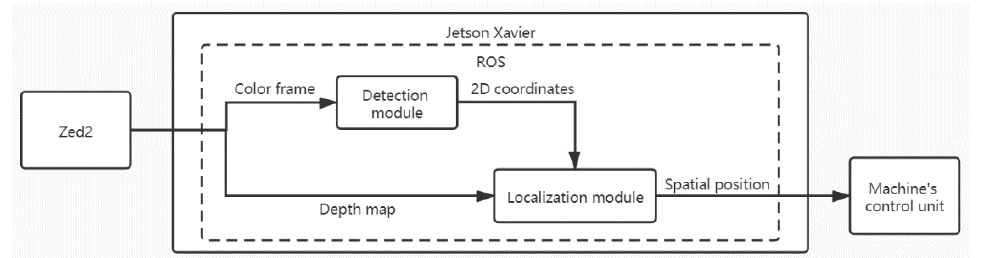
Figure 2. The system workflow for real-time object localization.